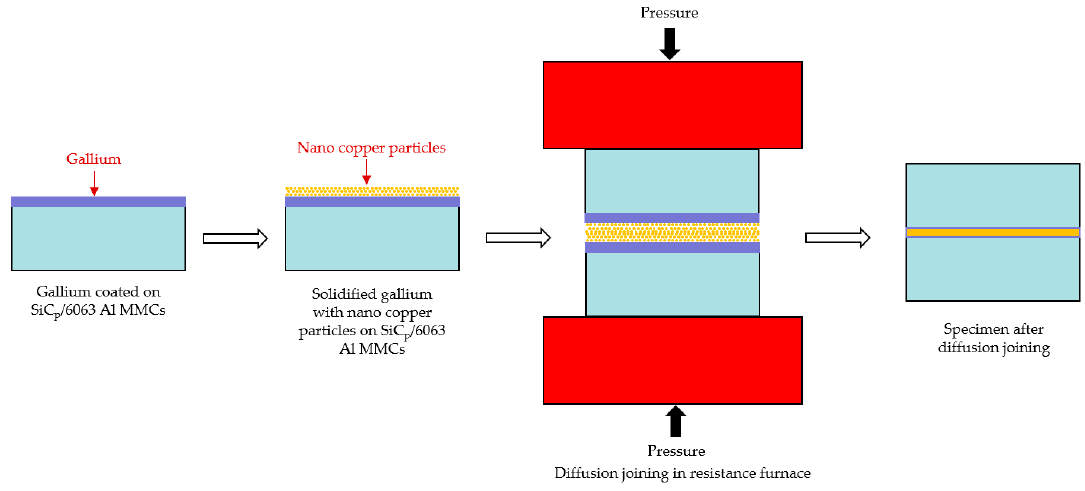
ff usion joining of SiC / 6063 Al p